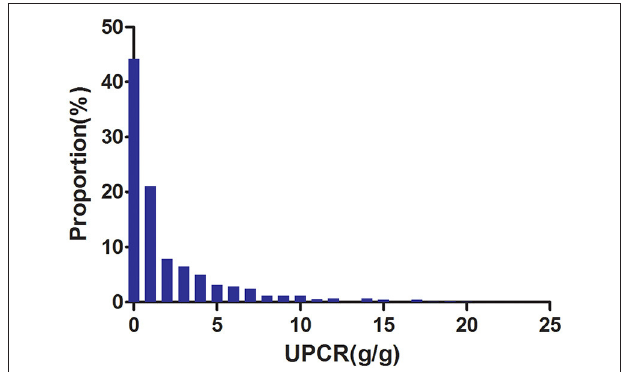
FIGURE 2 | Distribution of UPCR. It presented a skewed distribution while being in the range from 0.006 to